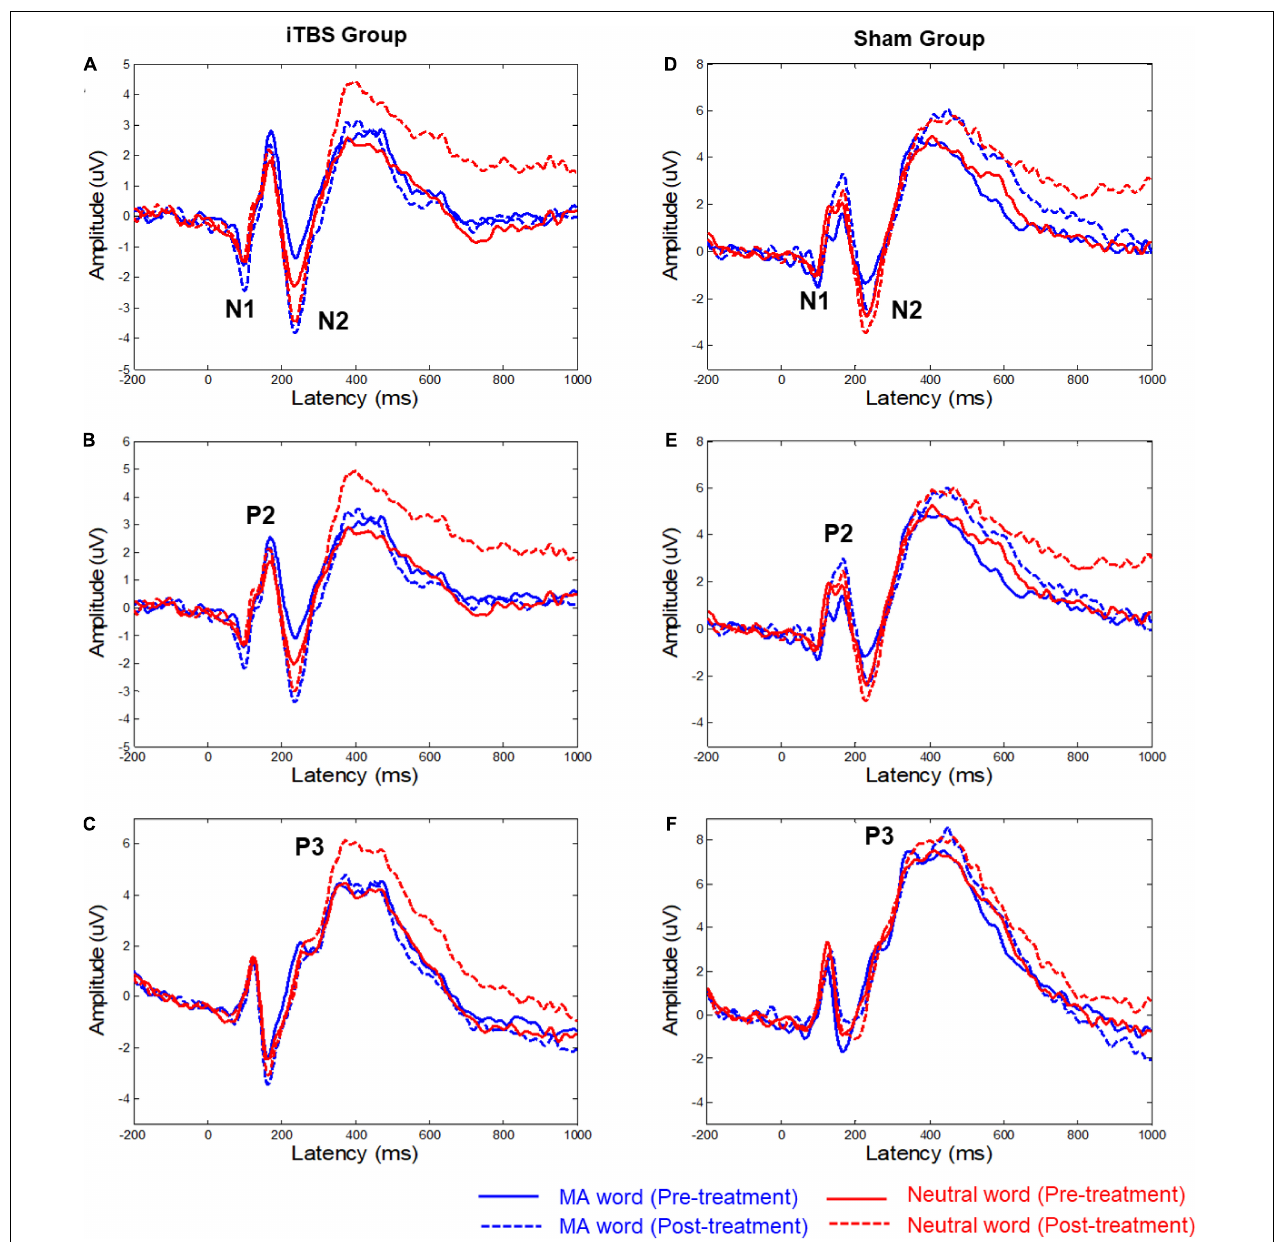
FIGURE 1 | Grand mean averages ( µ V) of event-related potentials to the two types of words in the two groups. (A,D) The average ERP waveforms of six electrodes (FZ/F1/F2/FCZ/FC1/FC2), the time-by-group effect was significant ( p = 0.04) on N1 Amplitude MA − Neutral . (B,E) The average ERP waveforms of six electrodes (FZ/F3/F4/FCZ/FC3/FC4). (C,F) The average ERP waveforms of six electrodes (CPZ/CP3/CP4/PZ/P3/P4). The significant time-by-group effect was identified based on P3 latency MA − Neutral ( p = 0.02). MA,